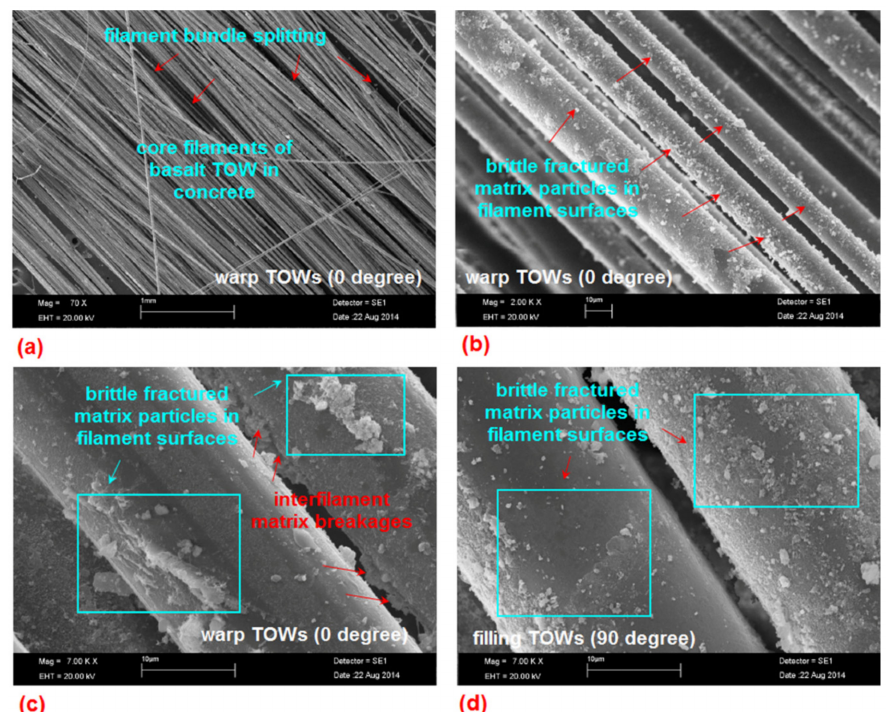
Figure 21. SEM graphs of the failed multiaxis 3D basalt fiber concrete. ( a ) B-1D (the scale bar 1 mm, magnification × 70); ( b ) enlarge view of failed fiber-matrix in B-1D (10 µ m, × 2000); ( c ) failed matrix in basalt warp TOW in B-2D (10 µ m, × 7000); ( d ) fractured filling fiber TOW in the B-2D concrete (10 µ m, × 7000).